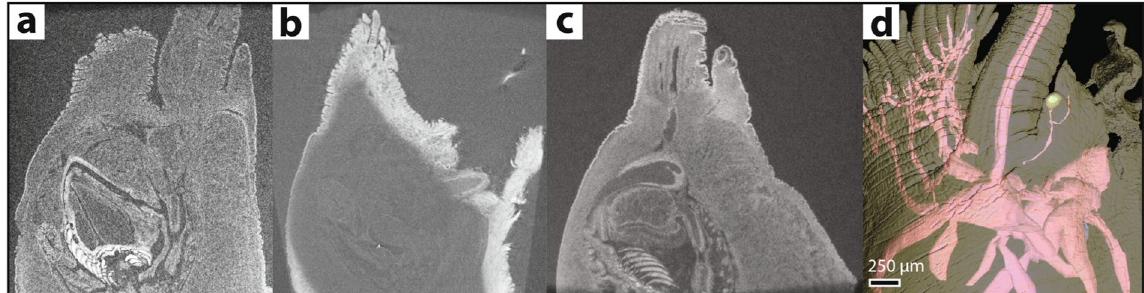
Figure 1. PTA staining substantially improves soft-tissue contrast in Elaphriella wareni . ( a ) Unstained biological tissues often have near-uniform X-ray absorption, giving low contrast in µ -CT scans and inhibiting their distinction. Inset: Ilanga navakaensis . Detail of eye from unstained specimen. ( b ) Contrast-enhancing stains such as phosphotungstic acid (PTA) have differential affinity to tissue types and facilitate their distinction, but incomplete penetration (as shown here) resulting from insufficient staining times may further inhibit feature reconstruction due to artefactual contrast variation across the sample and consequent problems in digital contrast enhancement. ( c ) Complete penetration by stain (13–14 days in this study) enables the distinction of additional tissues and at finer scales. ( d ) Reconstruction of fine neural structures based on PTA stained sample in ( c